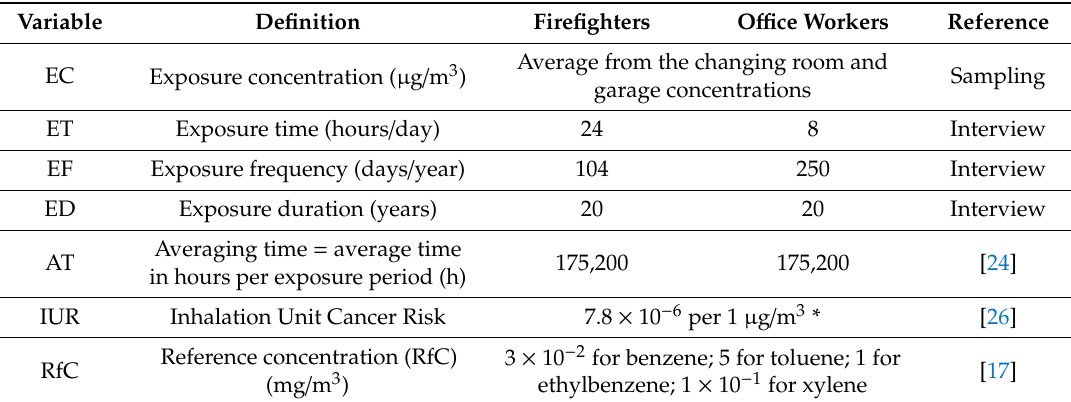
Table 1. Values of the factors used for the health risk